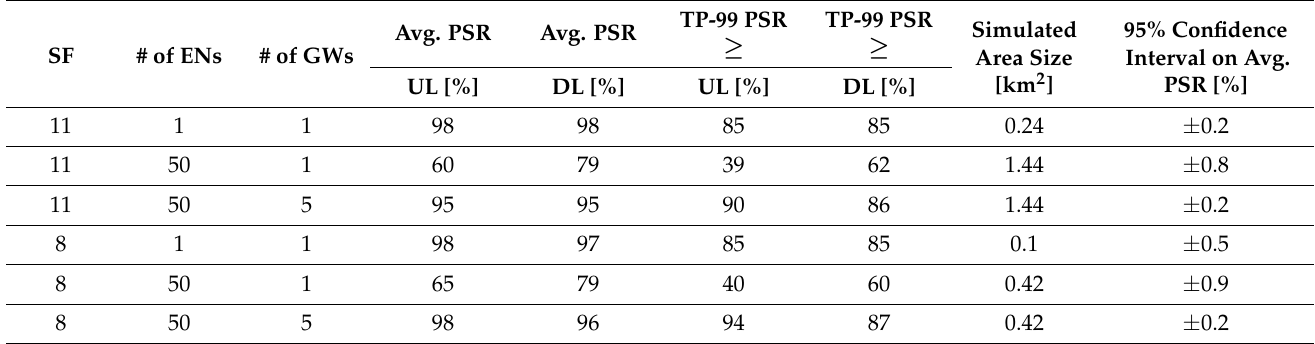
Figure 11. PER versus distance to each GW for a single EN in suburban terrain/with GW diversity. Table 3. PSR versus number of nodes in suburban terrain